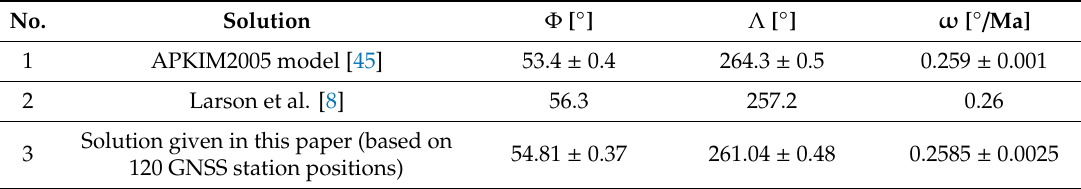
Figure 6. Results of the sequential solutions of the ω parameter for four calculation scenarios. Table 2. Comparison of the Eurasian plate motion parameters estimated in this paper with solutions derived by Drewes [45] and Larson et al.